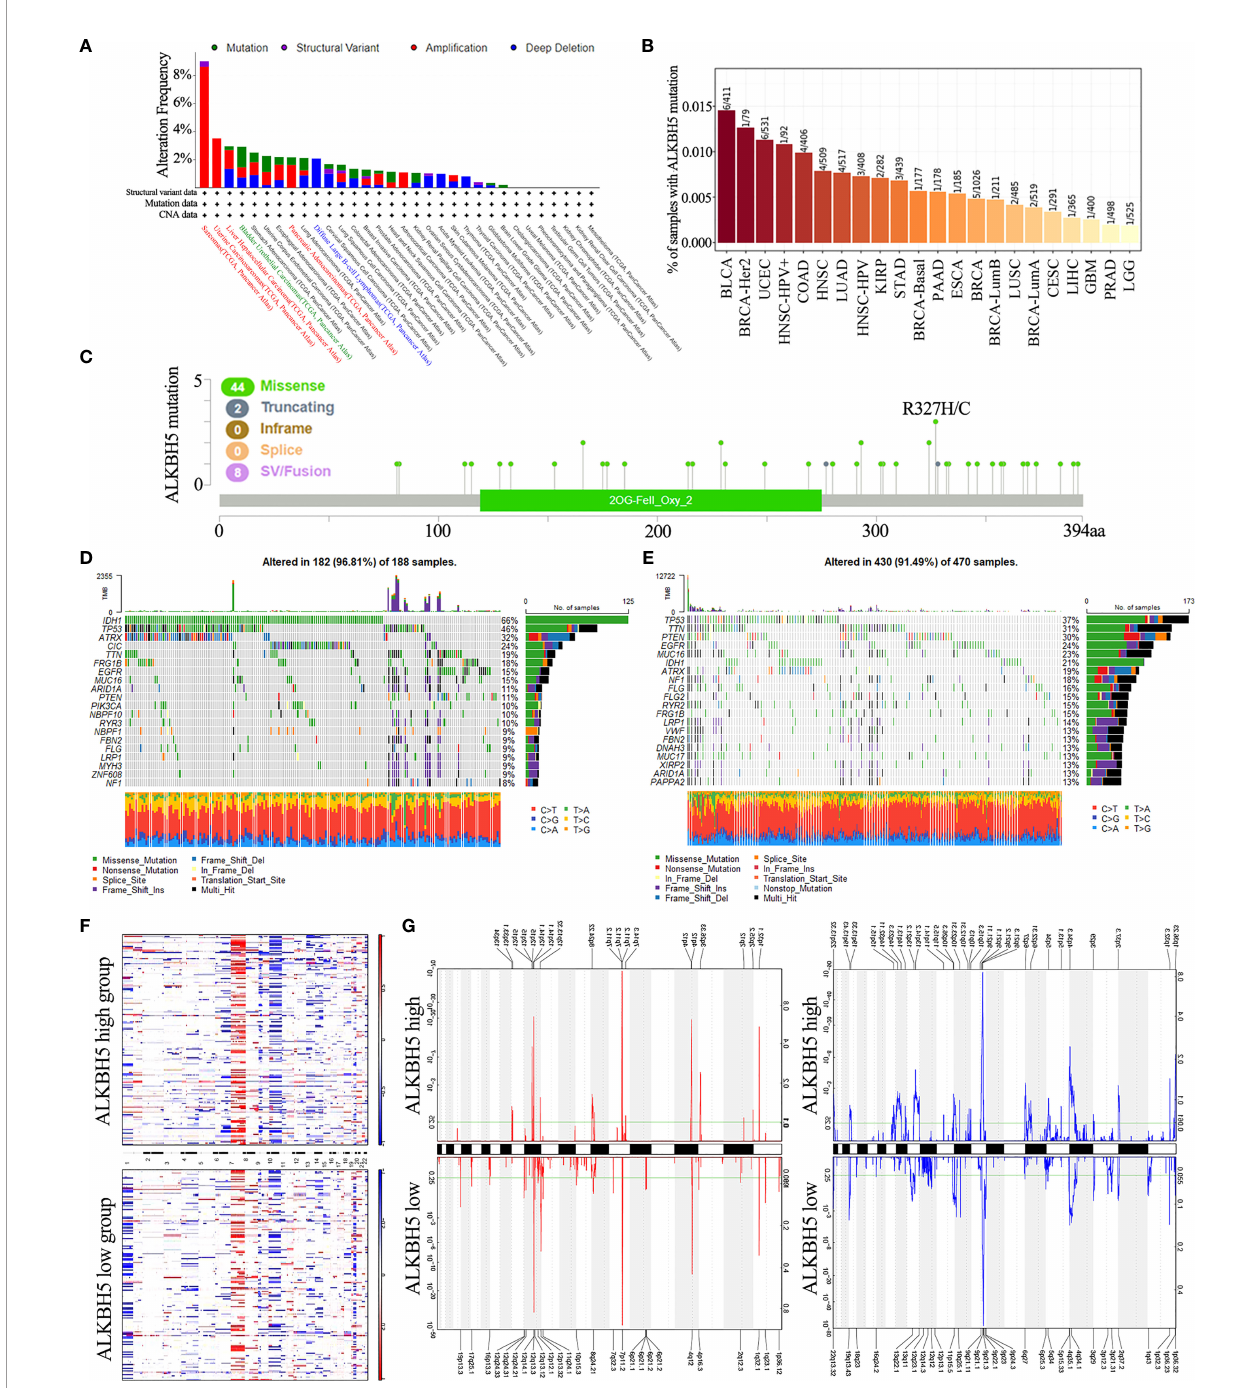
FIGURE 3 | Distinct genomic pro fi les associated with ALKBH5 expression and integrative analysis of complex cancer genomics and clinical pro fi les. (A) Genetic alteration features (Mutation, Structural Variant, Ampli fi cation and Deep Deletion) of ALKBH5 in 32 different tumors were analyzed in TCGA database by the cBioPortal tool. The red label represented the tumors with the top 3 levels of ampli fi cation. The green label represented the tumor with the highest mutation level and the blue label represented the tumor with the highest deep deletion level; (B) Mutation rates of ALKBH5 gene in various tumors via TIMER portal; (C) The mutation sites of ALKBH5 in multiple tumors by the cBioPortal tool. Detection of differential somatic mutations in gliomas, including 25% ALKBH5 low group (D) and 25% ALKBH5 high group (E) . Only the top 20 genes with the highest mutation rates were shown; (F) The CNAs pro fi le analysis about 25% ALKBH5 low group and 25% ALKBH5 high group in TCGA dataset via GISTIC2.0; (G) Frequency of ampli fi cations and deletions in gliomas with low and high ALKBH5 expression (Blue, deletion; red, ampli fi